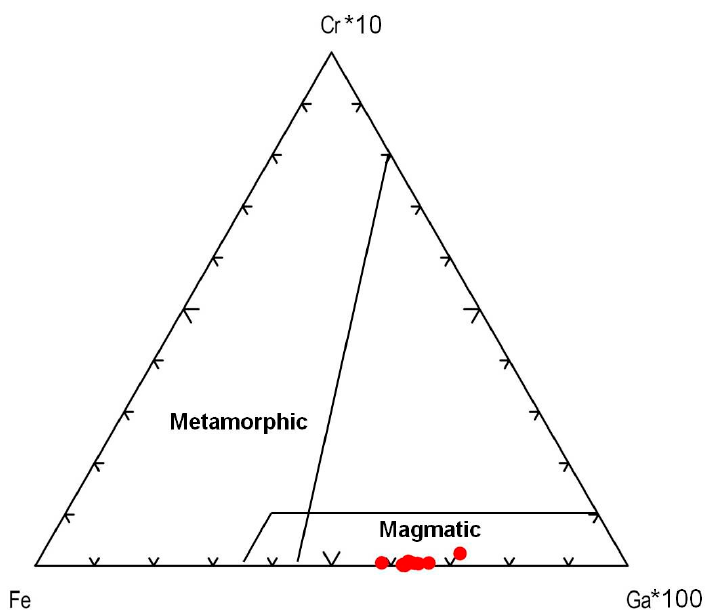
Figure 10. A Fe–Cr*10–Ga*100 ternary plot modified after Sutherland et al. (2009) [36].